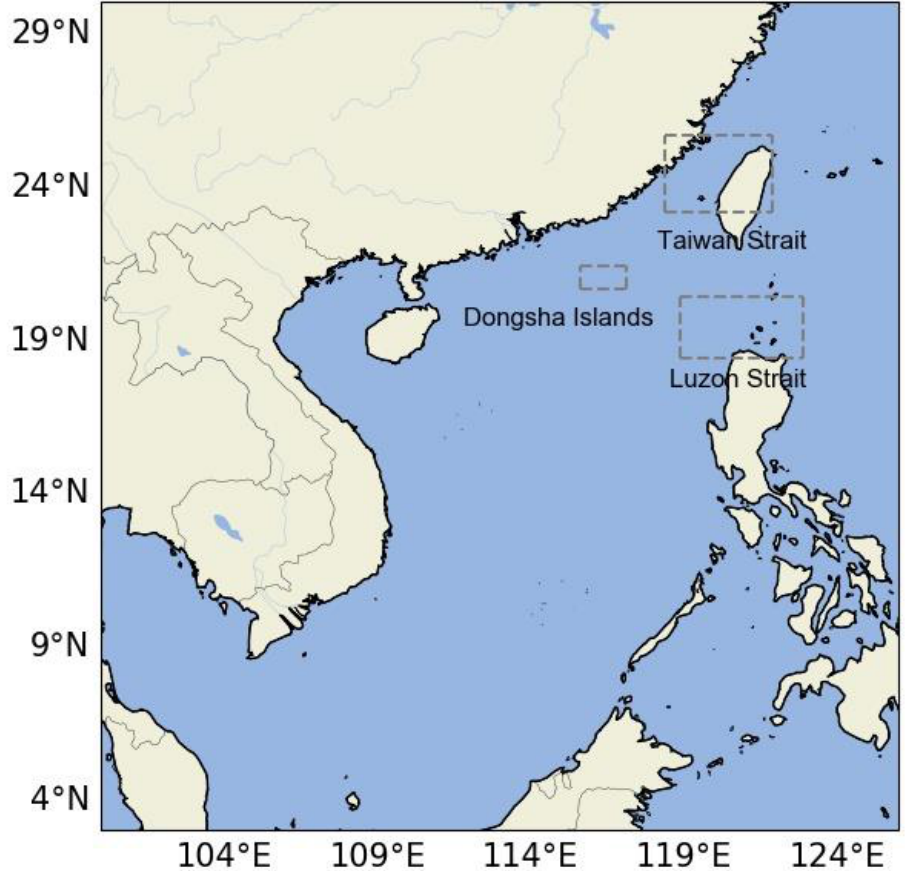
Figure 8. The geographic regions of the dominant sea areas.